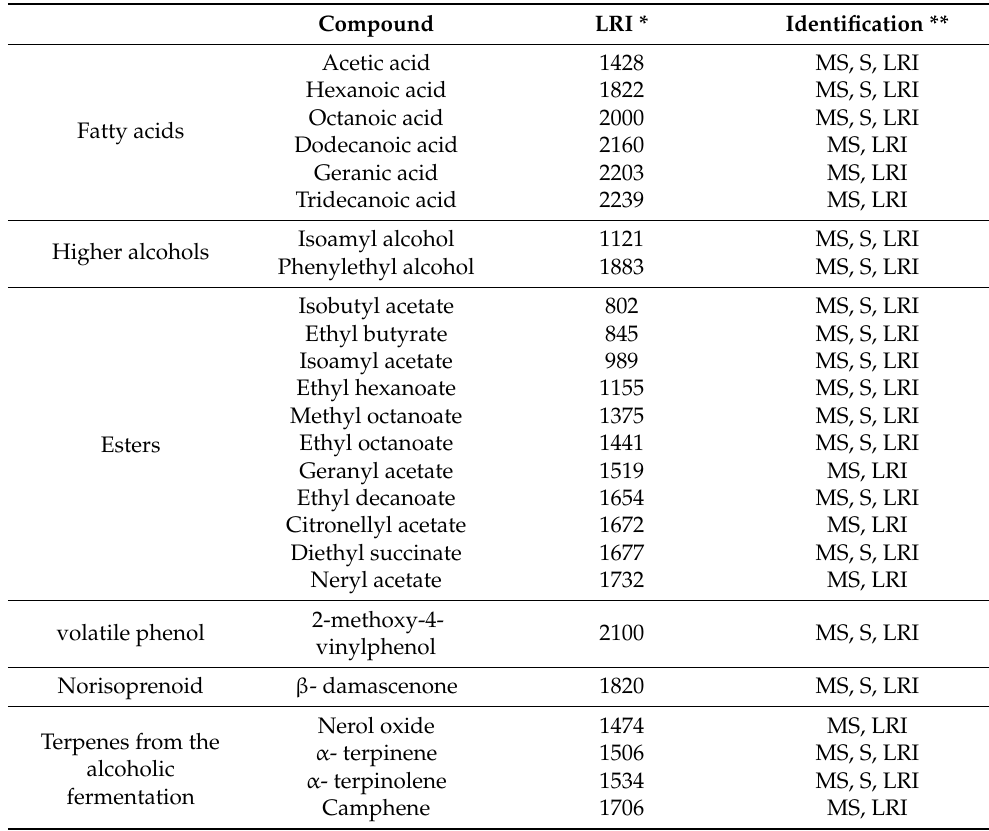
Table 2. Volatile compounds found in the final wines. The compounds were identified by their linear retention index or/and their mass spectra in SBSE-GC-MS